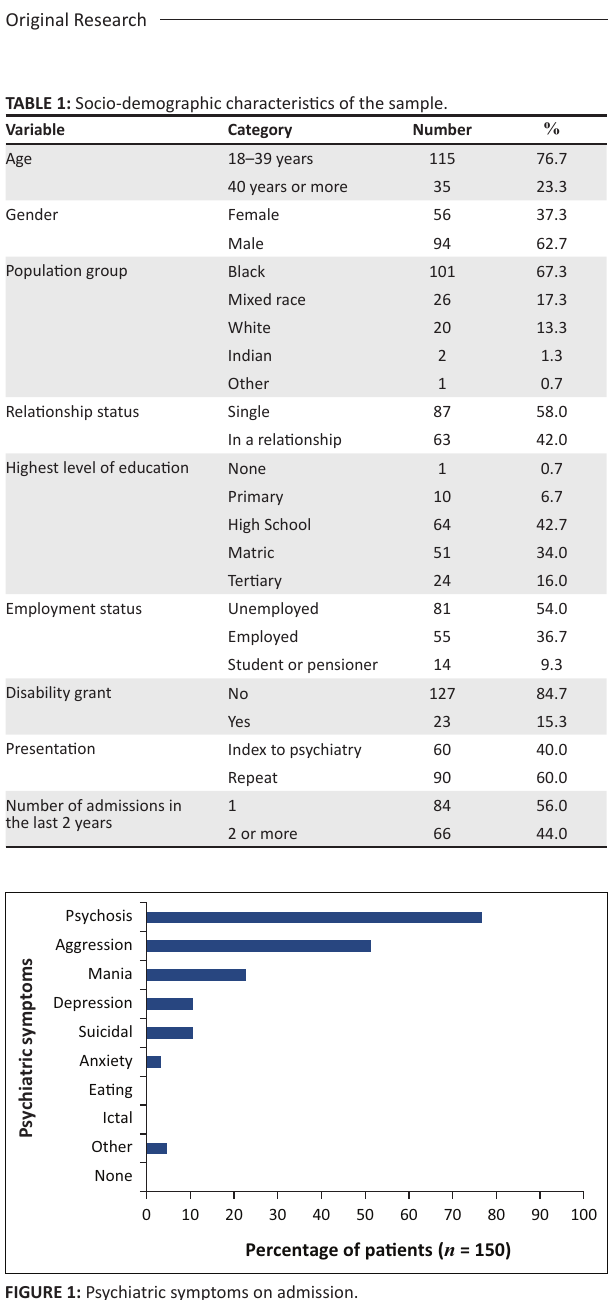
FIGURE 1: Psychiatric symptoms on